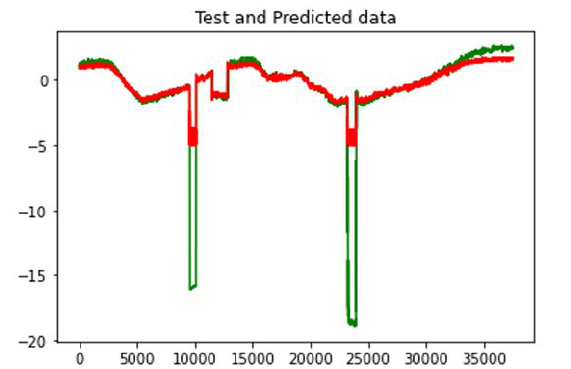
Figure 14. Testing and predicted data for FIT401 (predicted (red) and the actual values